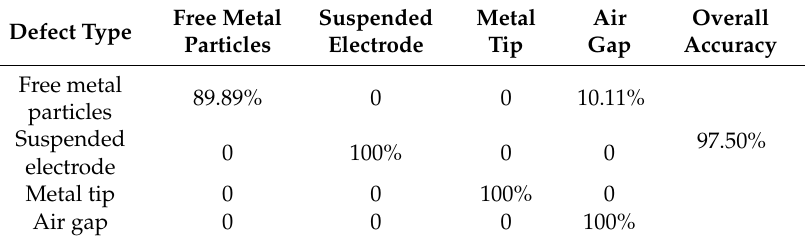
Table 3. Recognition rate of the statistical method.